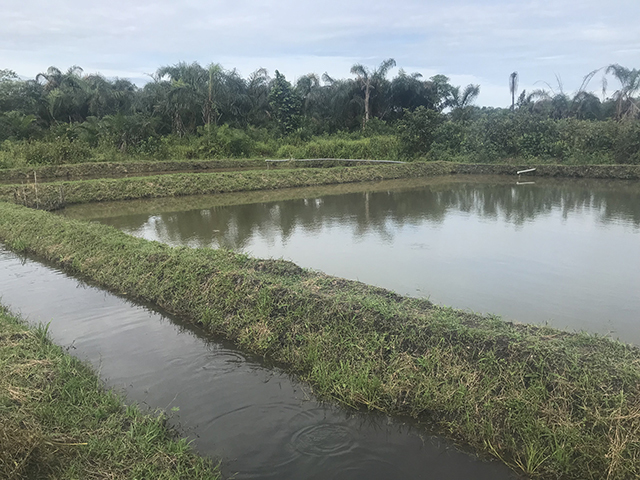
The on-site aquaculture farm was developed to provide a source of nutrition and revenue to support the Center’s operations.